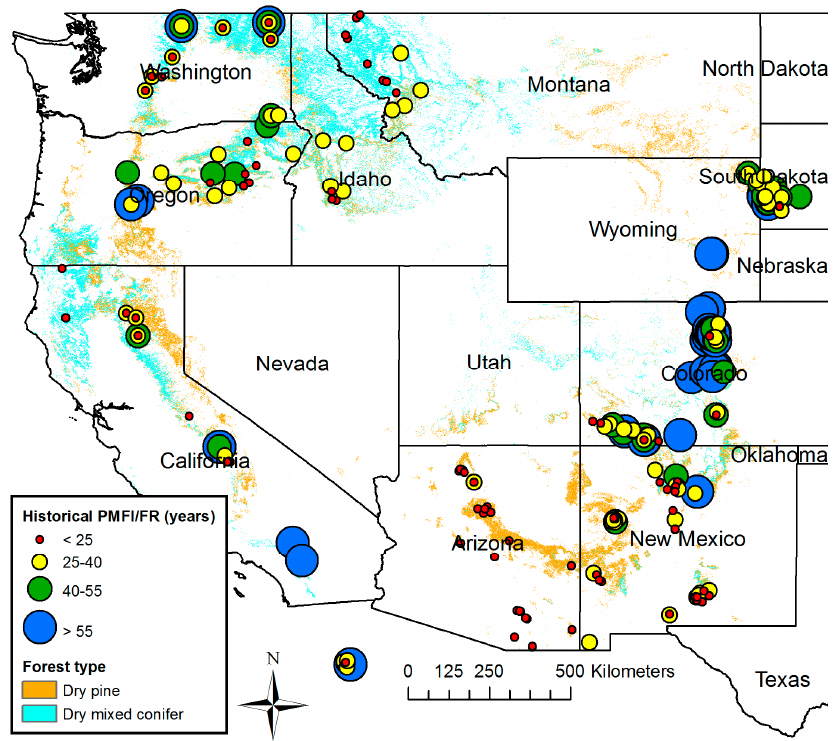
Figure 8. “Estimated historical low-severity population mean fire interval/fire rotation (PMFI/FR) for the combined set ( n = 342) of calibration cases and prediction sites in dry forests of the western USA”. Reprinted from [25] with permission from PLoS One.